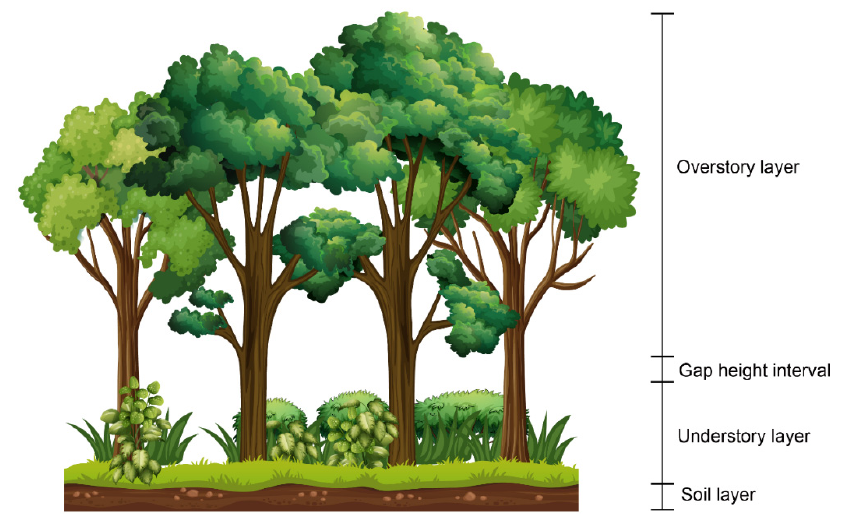
Figure 1. Depiction of overstory, understory, and soil layers and gap height interval.